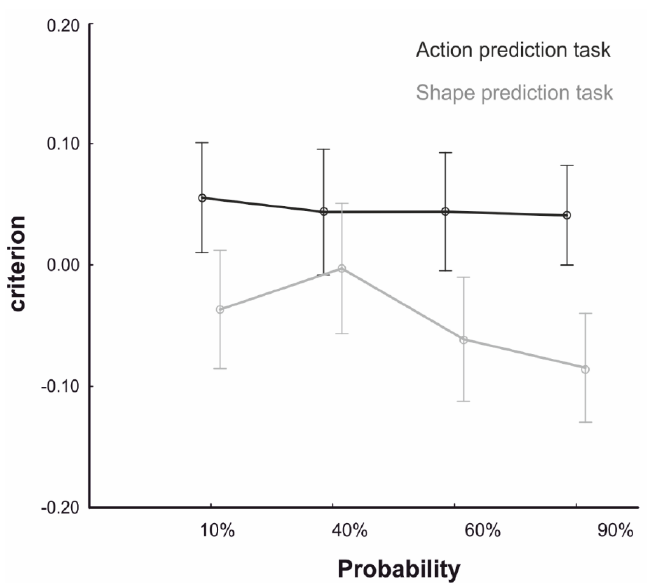
Figure 3. Behavioural results. Participants’ response biases in predicting the action (black line) and the shape identity (grey line) for the four probability conditions (10%, 40%, 60%, 90%) expressed as criterion (c). Data points represent group averages. Error bars represent SEM.